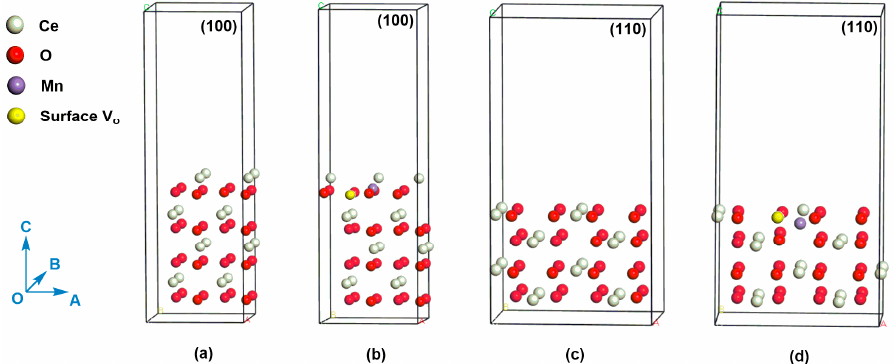
Figure 9. ( a ) (100) slab model for CeO 2 , ( b ) (100) slab model for Mn-doped CeO 2 with an oxygen vacancy, ( c ) (110) slab model for CeO 2 , ( d ) (110) slab model for Mn-doped CeO 2 with an oxygen vacancy. The white, red, purple, and yellow atoms refer to Ce atom, O atom, Mn atom, and surface oxygen vacancy, respectively.